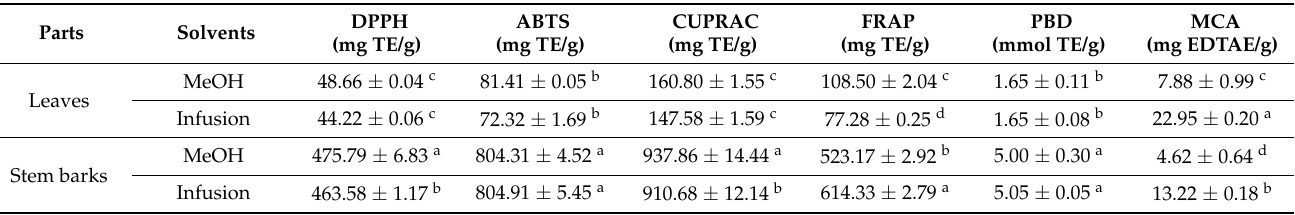
Table 3. Antioxidant properties of Ficus sur